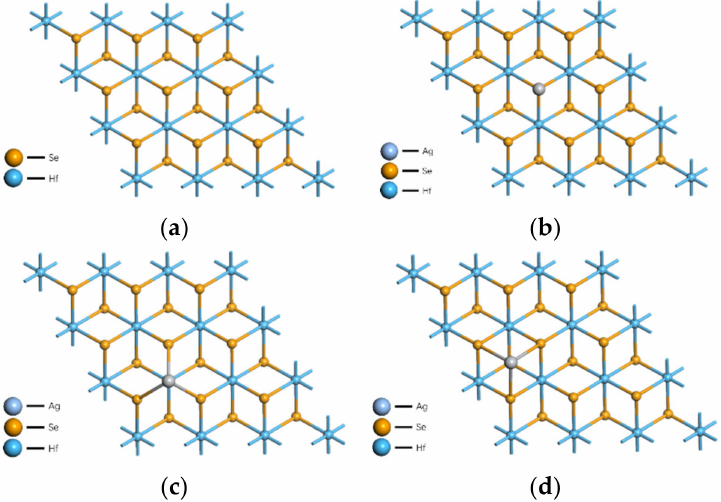
Figure 2. HfSe 2 pristine and three types of Ti doping. ( a ) HfSe 2 pristine; ( b ) above the upper-layer Se; ( c ) above the Hf; ( d ) above the lower-layer